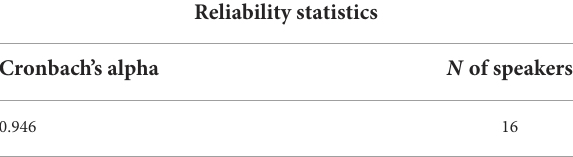
TABLE 4 Cronbach’s alpha reliability score on speakers’